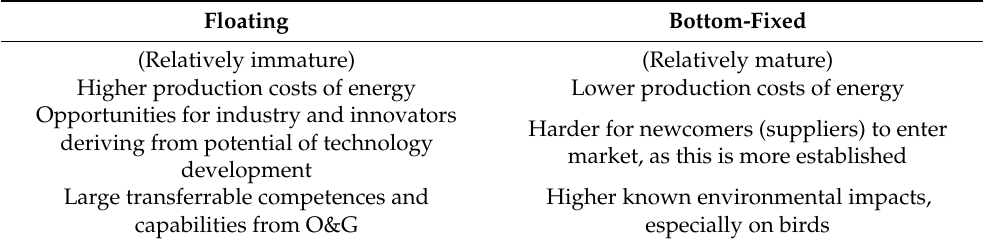
Table 1. Main differences between floating and bottom-fixed wind technologies. Floating Bottom-Fixed (Relatively immature) (Relatively mature) Higher production costs of energy Lower production costs of energy Opportunities for industry and innovators Harder for newcomers (suppliers) to enter deriving from potential of technology market, as this is more established development Large transferrable competences and Higher known environmental impacts, capabilities from O&G especially on